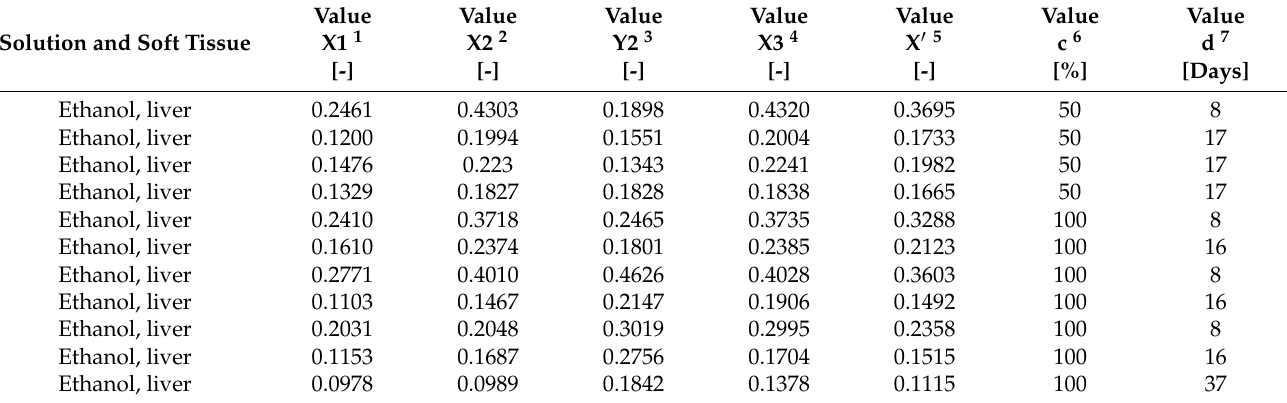
Table 2. Ethanol liver raw data for centroid and Spearman´s correlation coefficient computation.